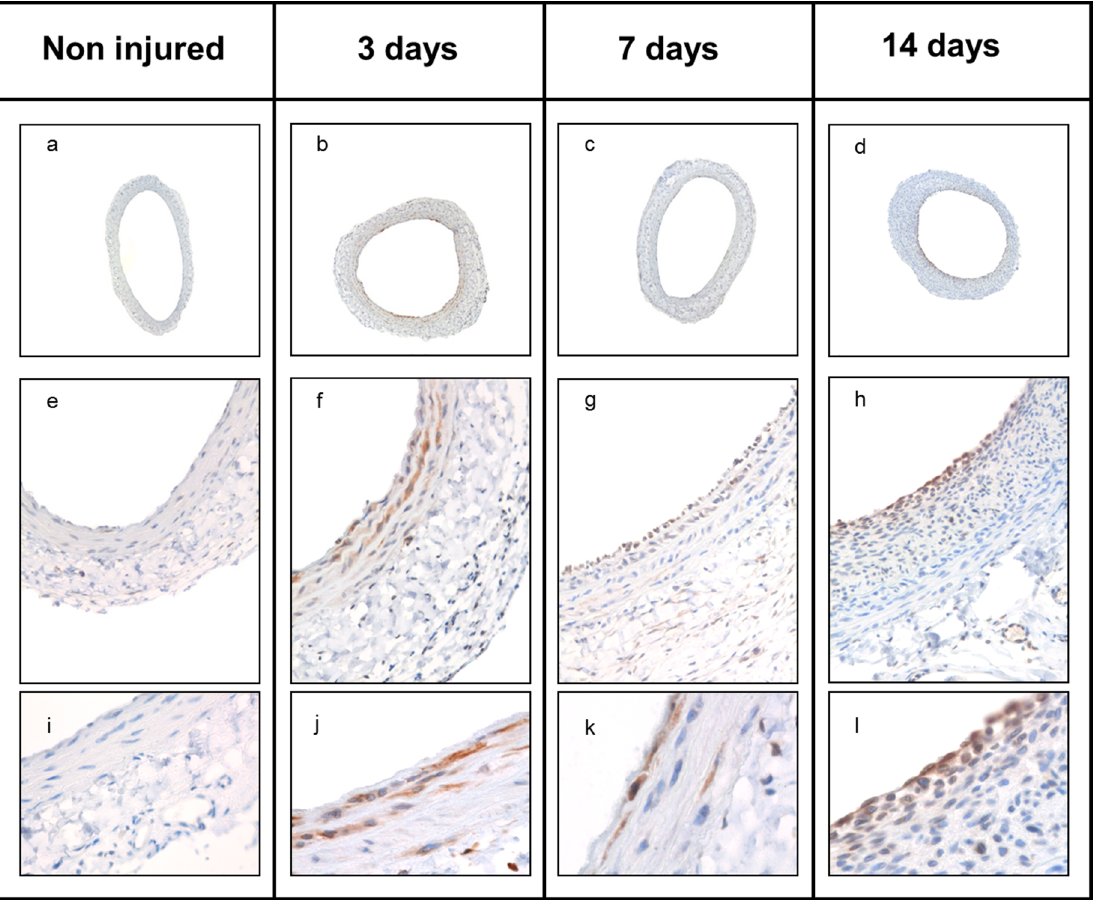
Figure 3. RanGAP1 expression in the rat carotid artery injury model. To determine the spatiotemporal expression pattern of RanGAP1 during the course of neointima formation, the rat carotid injury model was applied. Immunohistochemical staining revealed upregulation of RanGAP1 at day 3 (b, f, j, and day 7 (c, g, k) whereas RanGAP1 expression ceased when SMC proliferation decreases at day 14 (d, h, l) subsequent to balloon injury.